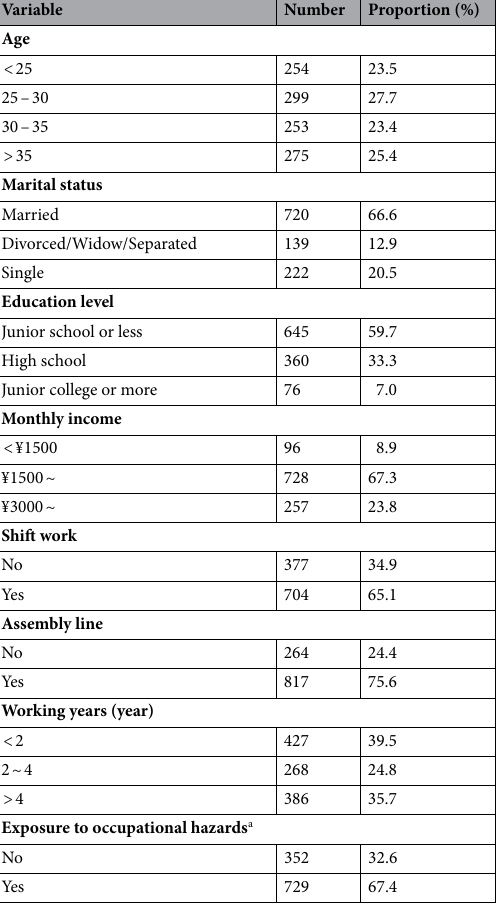
tional exhaustion and depersonalization. There was a lack of significant correlation between the MBI-GS and job control. The relationship between job burnout and occupational stress. The relationship between job burnout and occupational stress in the hierarchical linear regression analyses is presented in Table 4. The control variables (age, marital status, educational level, monthly income, shift work, assembly line, working years and exposure to occupational hazards) significantly predicted emotional (Δ R 2 = 0.057), depersonalization (Δ R 2 = 0.031) and professional efficacy (Δ R 2 = 0.044) in step 1. Emotional exhaustion was positively associated with overcommitment, effort, and job demand and significantly reversely associated with social support and rewards. In the case of depersonalization, high levels of depersonalization were associated with high overcom- mitment and job demand, low social support and low rewards. Social support, job demand and rewards posi- tively predicted professional efficacy. JDC and ERI were responsible for 23.5%, 19.6% and 4.6% of the variance in emotional exhaustion, depersonalization and professional efficacy, respectively. The relationship between job burnout and occupational stress in the logistic regression is shown in Table 5. After adjusting for age, marital status, educational level, monthly income, shift work, assembly line, work age and occupational hazards, female workers exposed to high job strain were associated with high emotional exhaustion (OR = 2.27, 95% CI : 1.61–3.20) and high depersonalization (OR = 1.96, 95% CI : 1.45–2.64). A high degree of social support can reduce the risk of emotional exhaustion (OR = 0.37, 95% CI : 0.26–0.53) and dep- ersonalization (OR = 0.49, 95% CI : 0.35–0.67), indicating that high social support is a mitigating factor of job burnout. Compared to female workers with low effort-reward imbalance, female workers with moderate and high effort-reward imbalance had a 2.45 times (95% CI : 1.66–3.61) and 2.88 times (95% CI : 1.89–4.38) risk of presenting emotional exhaustion, respectively. Compared to female workers with low effort-reward imbalance, female workers with high effort-reward imbalance had an increased risk of high depersonalization (OR = 1.96, 95% CI : 1.33–2.90). Moderate overcommitment can improve personal efficacy (OR = 1.52, 95% CI : 1.11–2.07),